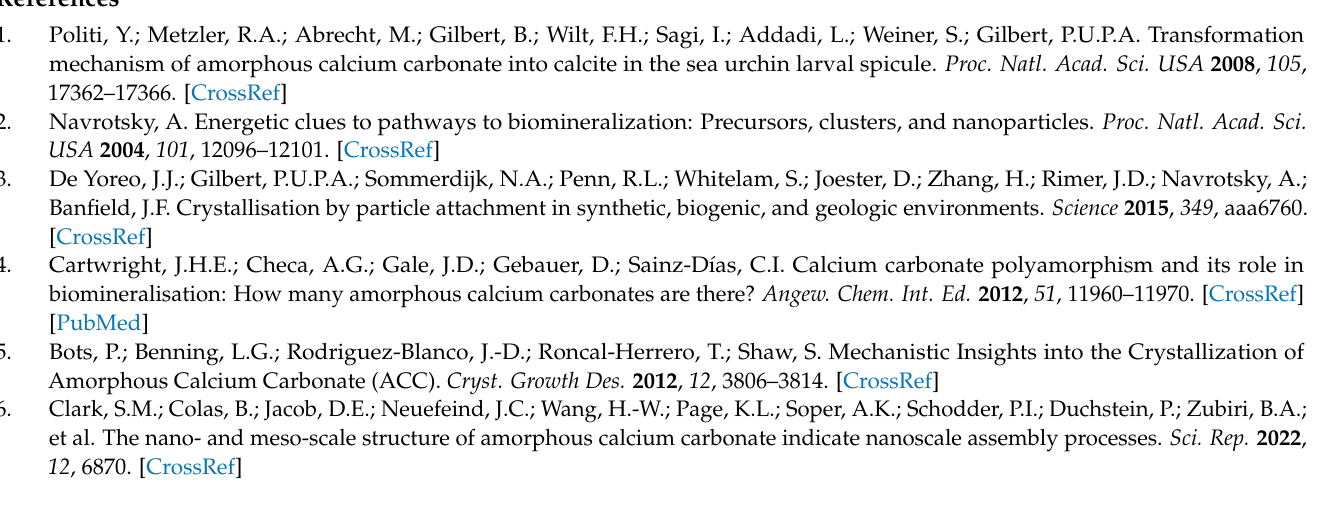
sample. Figure S2. X-ray powder diffraction pattern of our Mg-ACC sample with two diffuse maxima. Figure S3. X-ray scattering of solid-solution mixtures of (Ca 1 − x Mg x )CO 3 . Figure S4. Neutron scattering patterns of samples prepared with different Mg/Ca ratios. Figure S5. Neutron scattering data of H 2 O/D 2 O mixtures. Figure S6. Representative Raman spectrum. Figure S7. X-ray powder diffraction pattern of an ACC converted into aragonite. Figure S8. SEM micrograph of a synthesised sample from this study showing tablets of aragonite and xenomorphic aggregates believed to be ACC. Figure S9. SANS patterns evolving with time. Figure S10. XRD patterns during crystallization of aragonite from ACC. Table S1. Water content and Mg/Ca ratios determined for